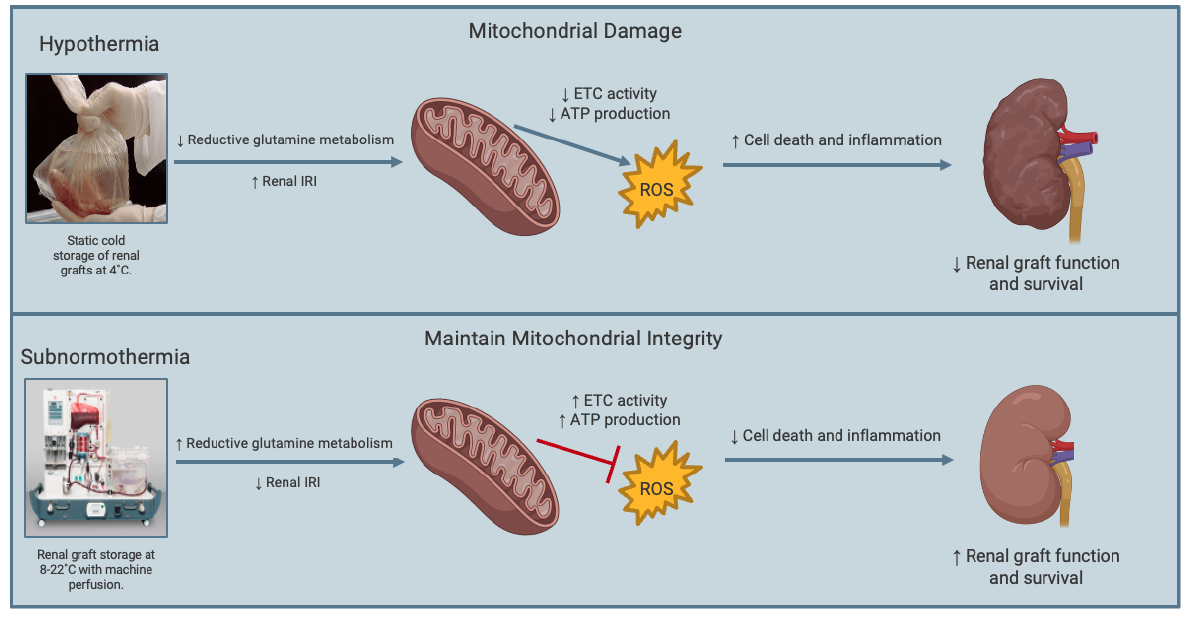
Figure 2. Schematic representation of the effects of subnormothermic and hypothermic renal graft preservation. Compared to static cold storage at 4 °C, subnormothermic temperatures (e.g., 8 – 22 °C) are associated with increased reductive glutamine metabolism, which reduces renal ischemia-reper- fusion injury. In turn, subnormothermia can increase electron transport chain (ETC) activity, which subsequently increases adenosine triphosphate (ATP) production and reduce generation of reactive oxygen species (ROS) to protect the mitochondria and reduce cell death and inflammation. This mechanism enhances renal graft function and survival. Figure prepared with BioRender (bioren- der.com).